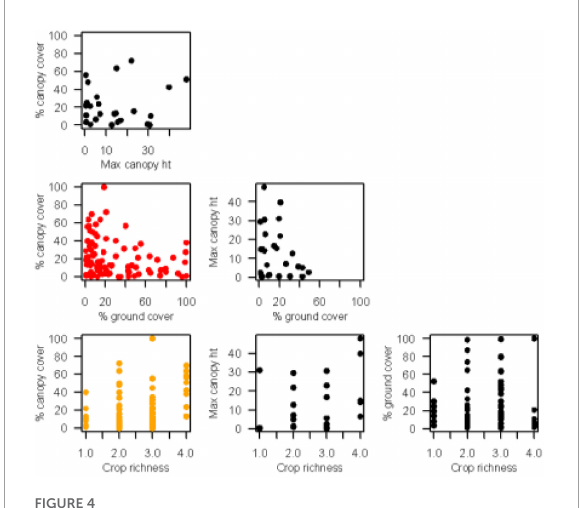
FIGURE4 Shows the Spearman Rank correlations for management variables considered in the coffee system studied. Black data points indicate non-significant relationships, yellow data points